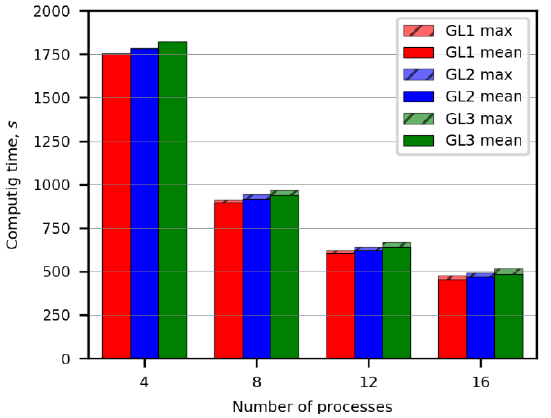
Figure 3. Load imbalance expressed by the maximum and mean computing times.